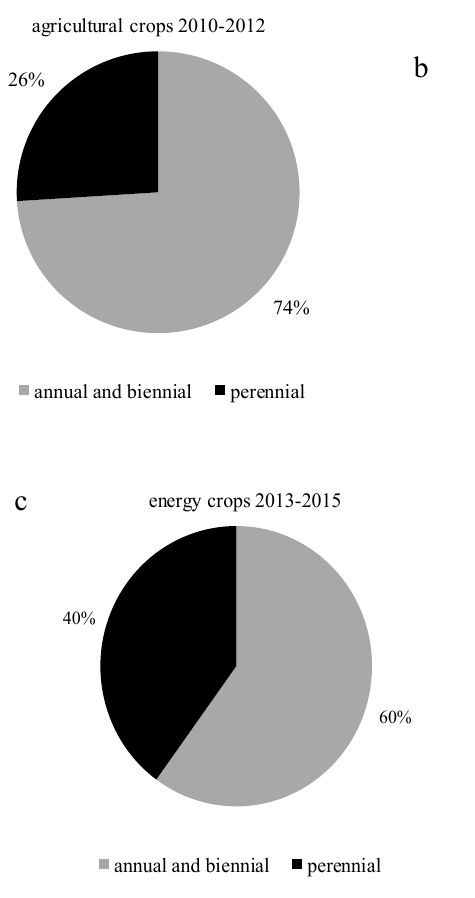
Figure 8. Percentage share of short-lived and perennial species in plant communities accompanying typical agricultural crops and energy crops. ( a ) agricultural crops in the years 2010-2012, ( b ) energy crops in the years 2010-2012, ( c ) energy crops in the years 2013-2015.